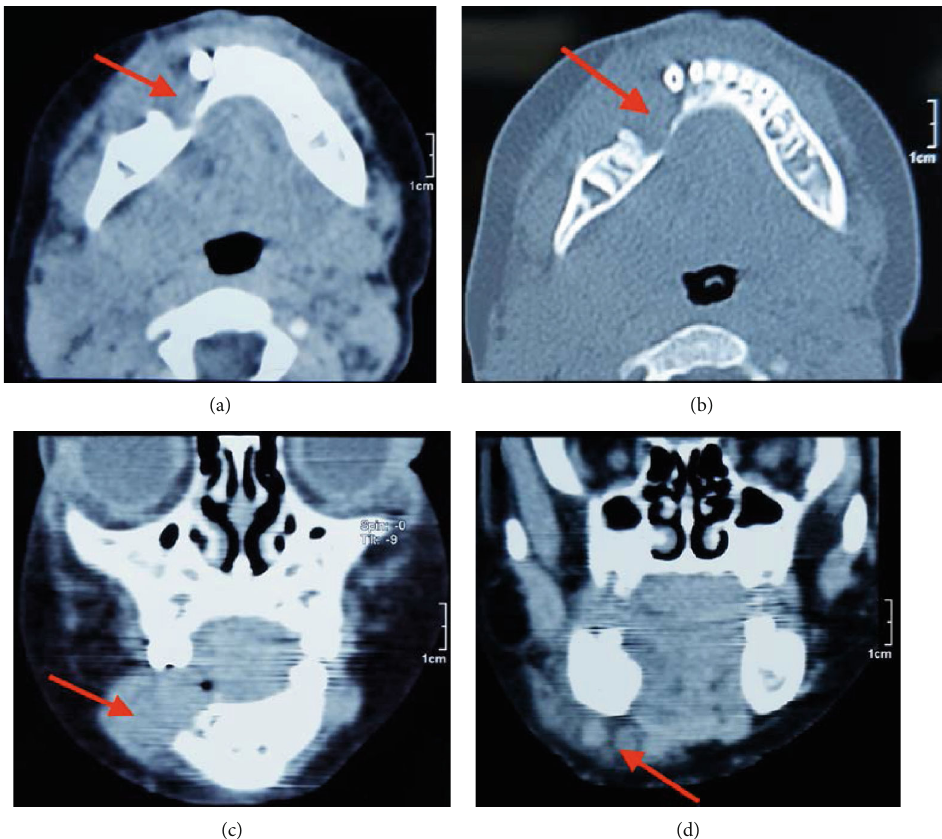
Figure 2: CT images showing a lesion with bony cortex perforation (red arrow, (a) and (b)) and soft tissue in fi ltration and lymph nodes involvement (red arrow, (c) and (d)).